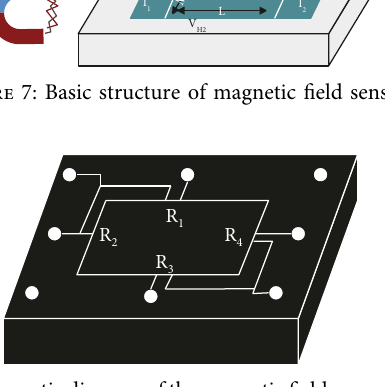
Figure 8: Schematic diagram of the magnetic field sensor structure.